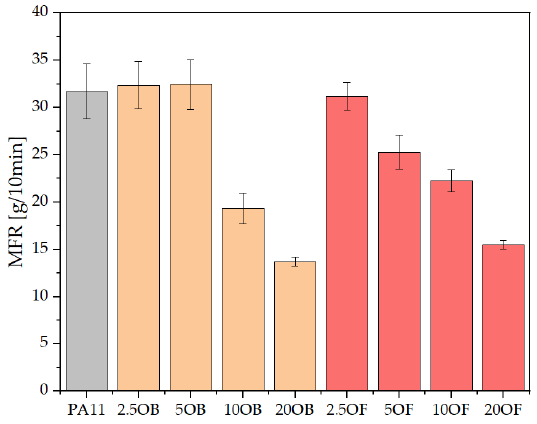
Figure 7. Melt flow rate (MFR) of biocomposites.